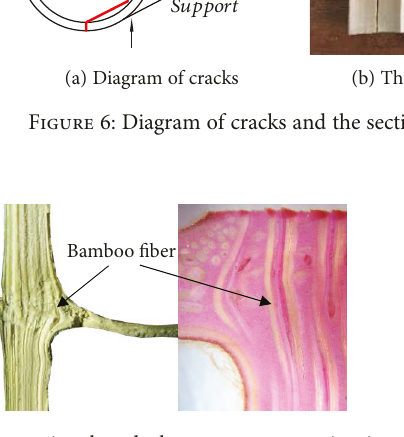
Figure 7: The sectional and electron macroscopic views of the internal diaphragm and external ridge of a bamboo